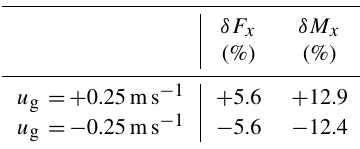
Table 2. Averaged rotor loads during the 1 − cos() gust in relation to the constant blade load.